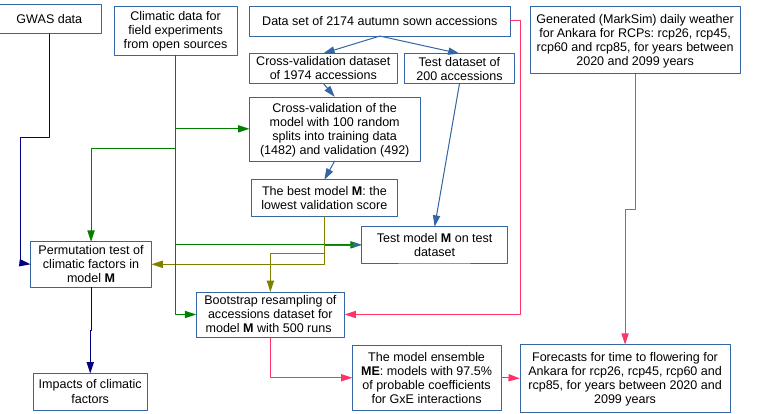
Figure 1. The overview of the research. The data sets, performed numerical experiments and results are shown as boxes on the diagram, while the arrows represent the data flow.